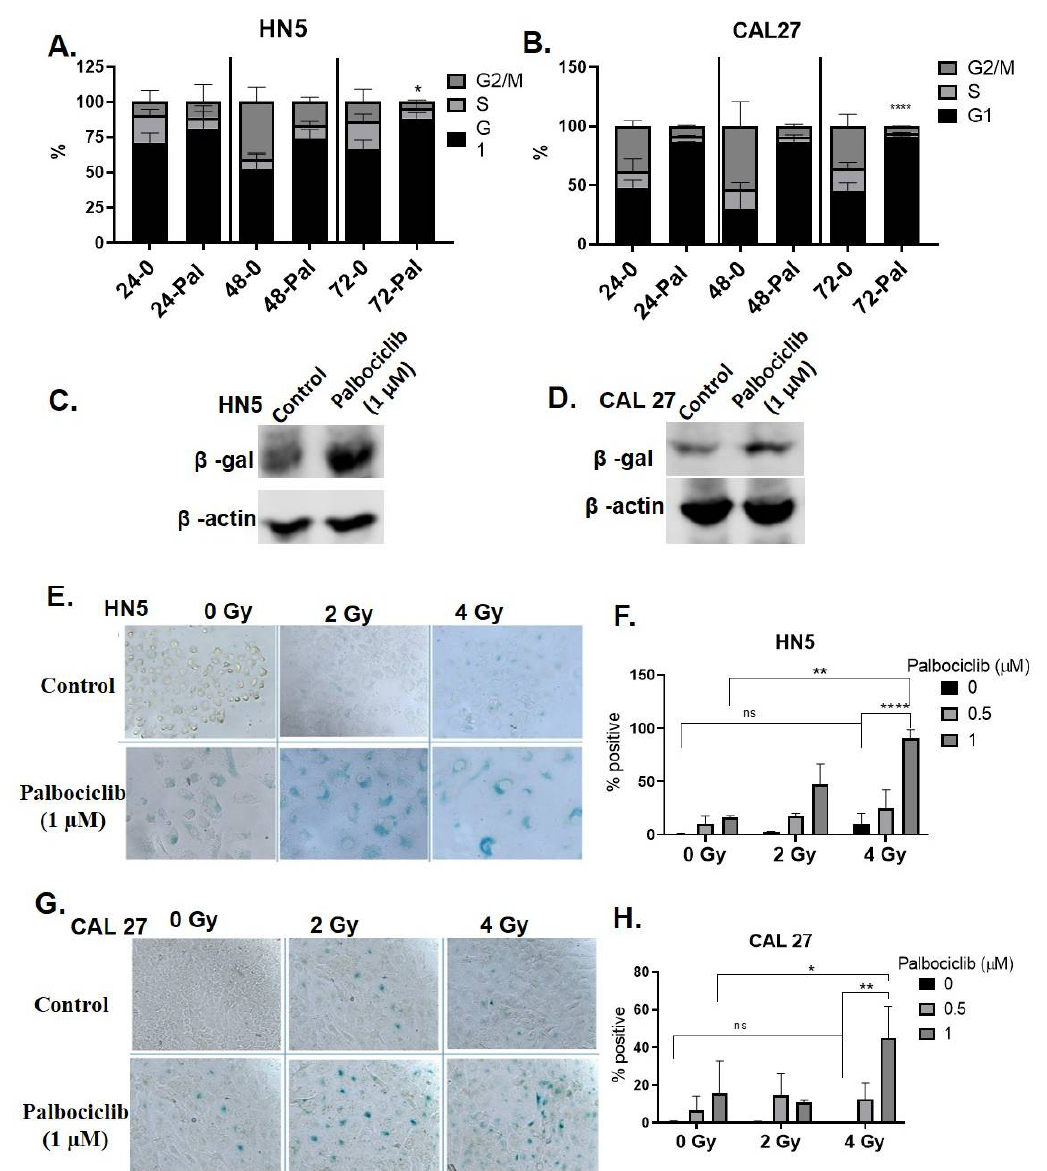
Figure 2. Palbociclib induces G1 arrest and senescence in HPV( − ) OCSCC when combined with radiation treatment. OCSCC cells grown for 72 h in drug medium exhibited cell cycle arrest in G1 phase in HN5 ( A ) and CAL27 ( B ). The 72 h treatment resulted in senescence with SA β -gal staining using western blot and colorimetric assay in HN5 ( C , E ) and CAL27 ( D , G ). The uncropped blots are shown in Supplementary Materials. Percent β -gal-positive cell quantification for HN5 ( F ) and CAL27 ( H ). Bright field images captured at 200 × . Scale: 200 µ m. A 72 h palbociclib/RT (1 µ M + 4 Gy) demonstrated highest levels of senescence ( β -gal-positive blue-stained cells) in both HN5 ( E , F ) and CAL27 ( G , H ). Analysis by two tailed t -test. * p < 0.05; ** p < 0.01; **** p < 0.0001. Each data point represents the average percent of three individual experiments. Gy—Gray; β -gal— β -galactosidase;